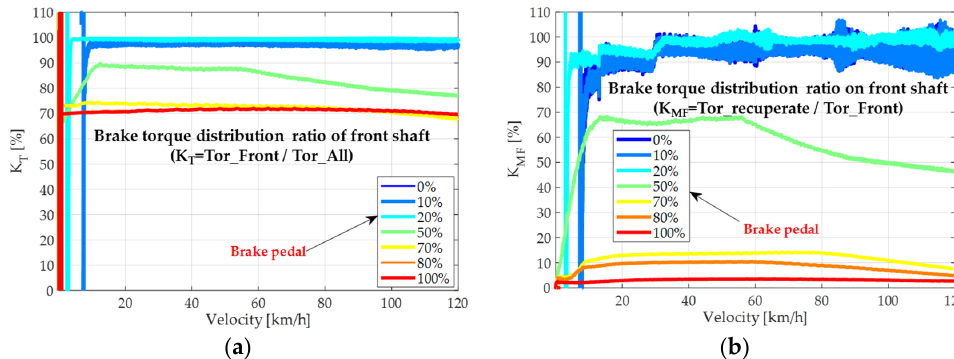
Figure 4. Brake torque distribution: ( a ) The brake force distribution between each shaft of the vehicle; ( b ) The electric-hydraulic brake force distribution on each axle.